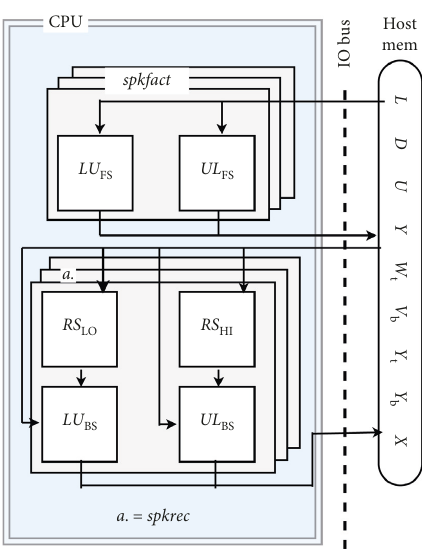
Figure 4: The CPU truncated SPIKE OpenCL kernels spkfact and spkrec , with the execution path and data dependencies shown. Both kernels are executed as an NDRange of work items.